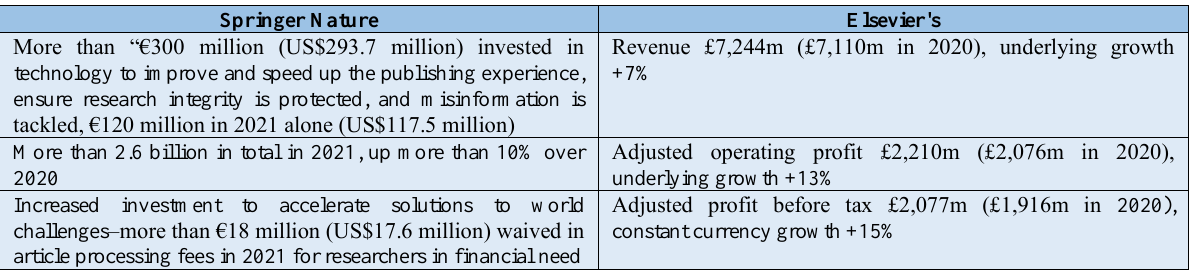
Table 2. Financial Performance of Representative Agents of the Publishing Academic